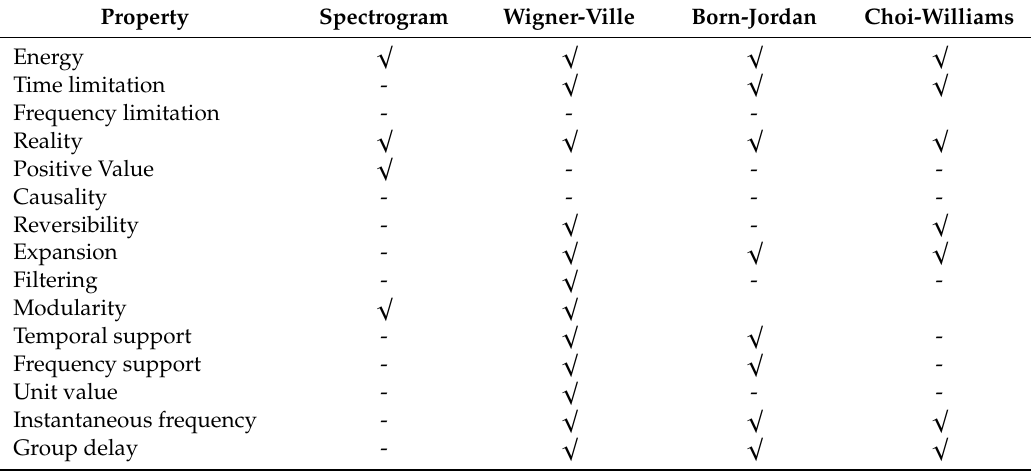
Table 1. Properties verified by several time-frequency representations in Cohen’s